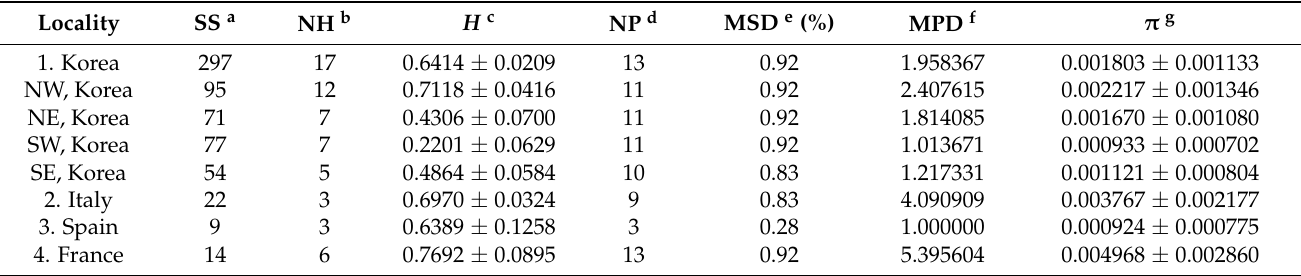
Table 2. Within-country and Korean regional diversity estimates of Metcalfa pruinosa based on concatenated sequences of the DNA barcoding region and Region